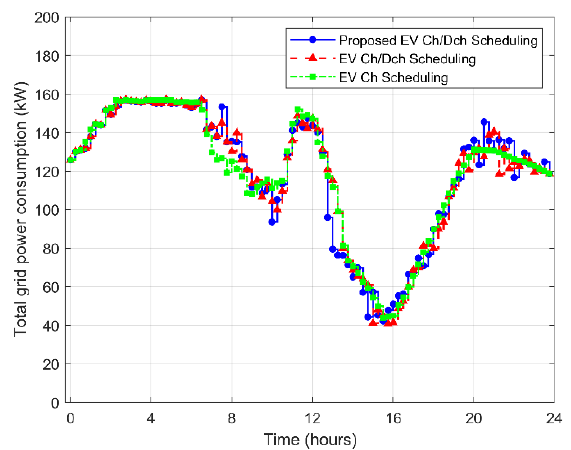
Figure 8. Total grid power consumption for interdependent MG and EV fleets.